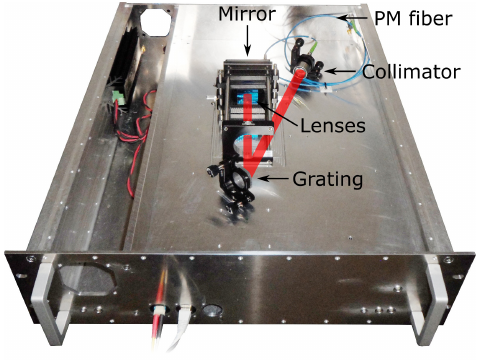
Figure 12. A photograph of a 19-inch spectrometer setup used at